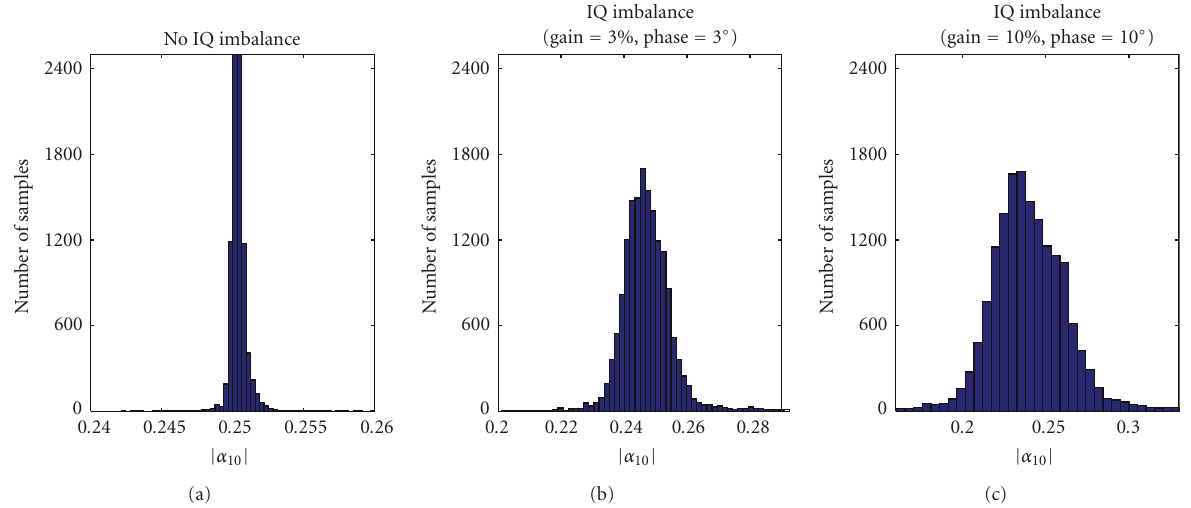
Figure 4: The variation histogram of the first MOP PD coe ffi cient with and without IQ imbalance.